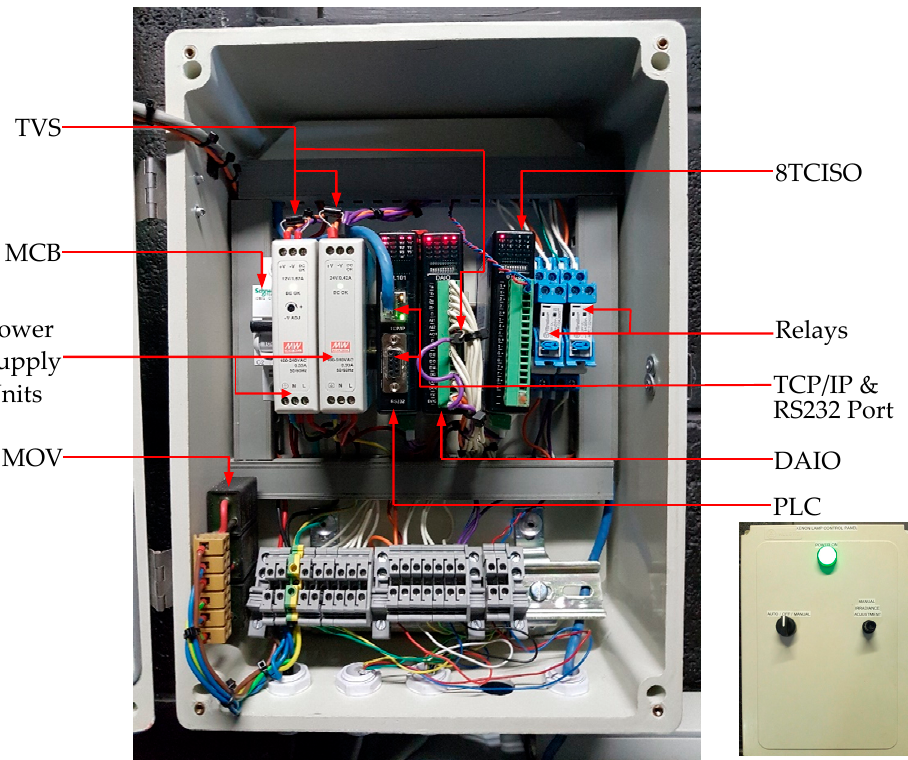
Figure 5. Autonomous dynamic adaptability system (ADAS).